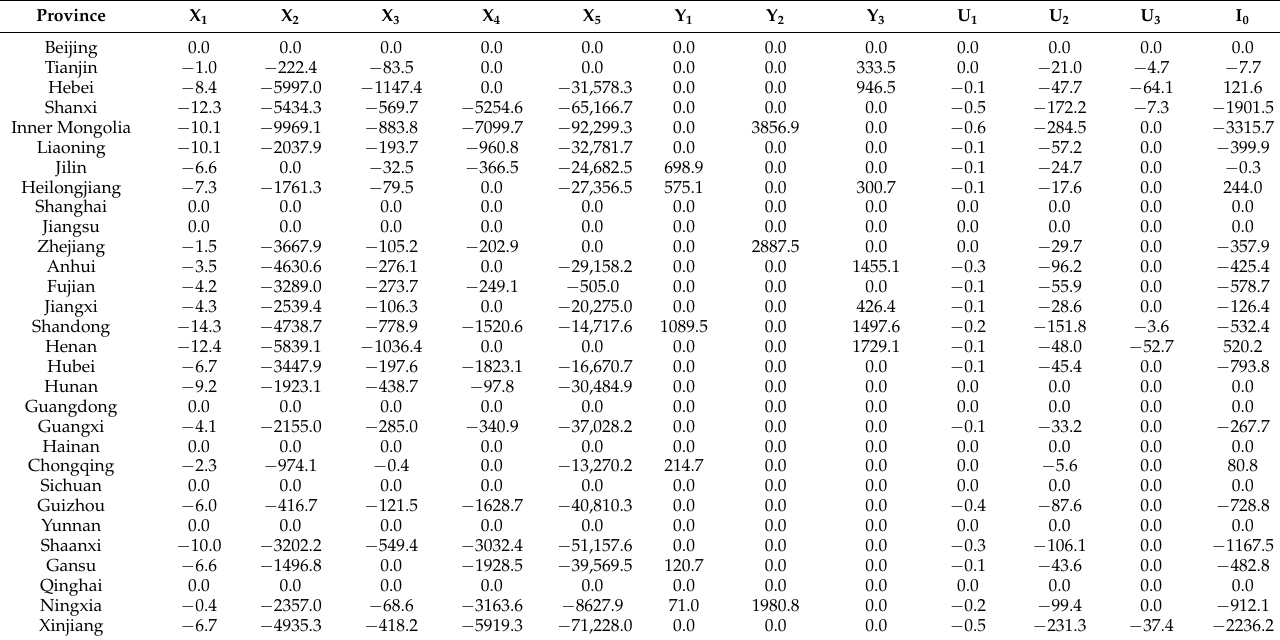
Table 5. The improvement of input-output indicators in 30 provinces and cities in China in